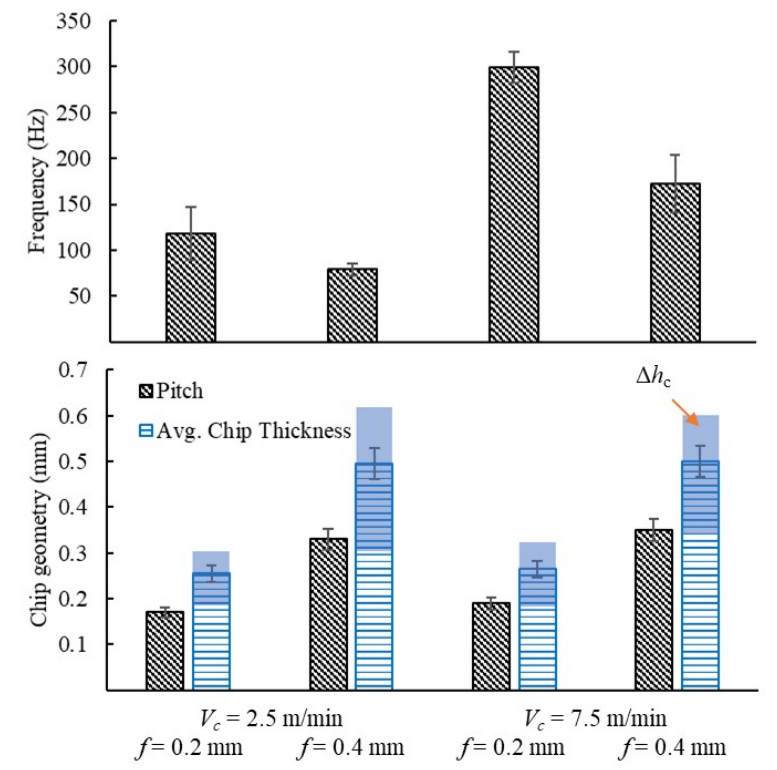
Figure 11. Effect of cutting conditions on oscillation frequency and chip geometry (experimental results).